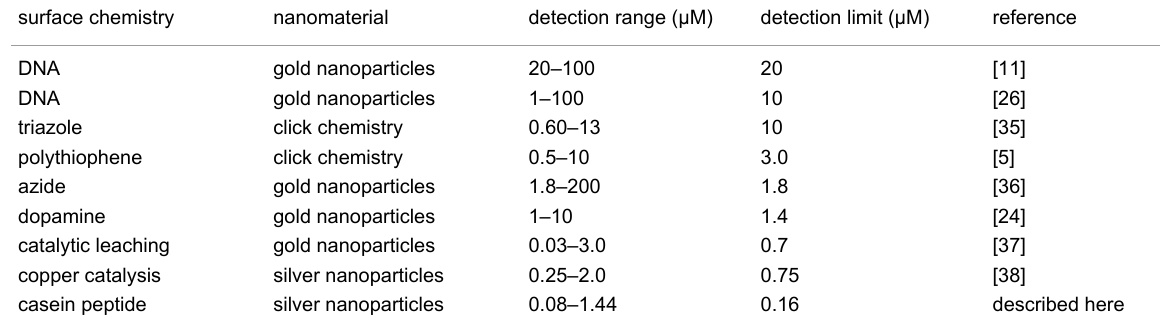
tration is significantly lower than that of 20 μ M reported by Xu et al. [11], and 5.0 μ M by Lu and Liu [26], using DNA-modi- fied NPs. Recently, colorimetric methods based on gold NPs have been widely reported for Cu 2+ detection (Table 1). How- ever, as mentioned above, such procedures are costly. The